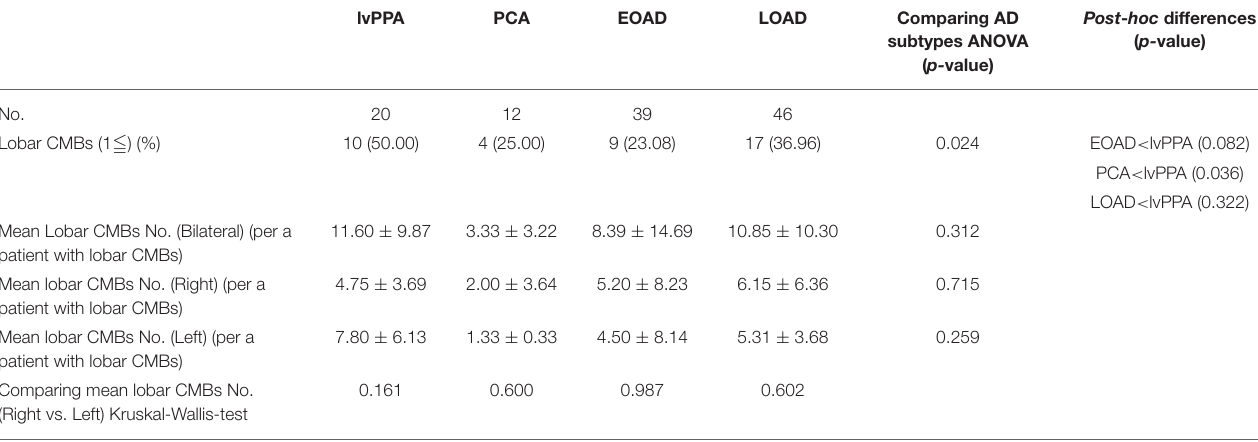
TABLE 3 | Prevalence and mean number of lobar CMBs in the four subtypes of AD patients.